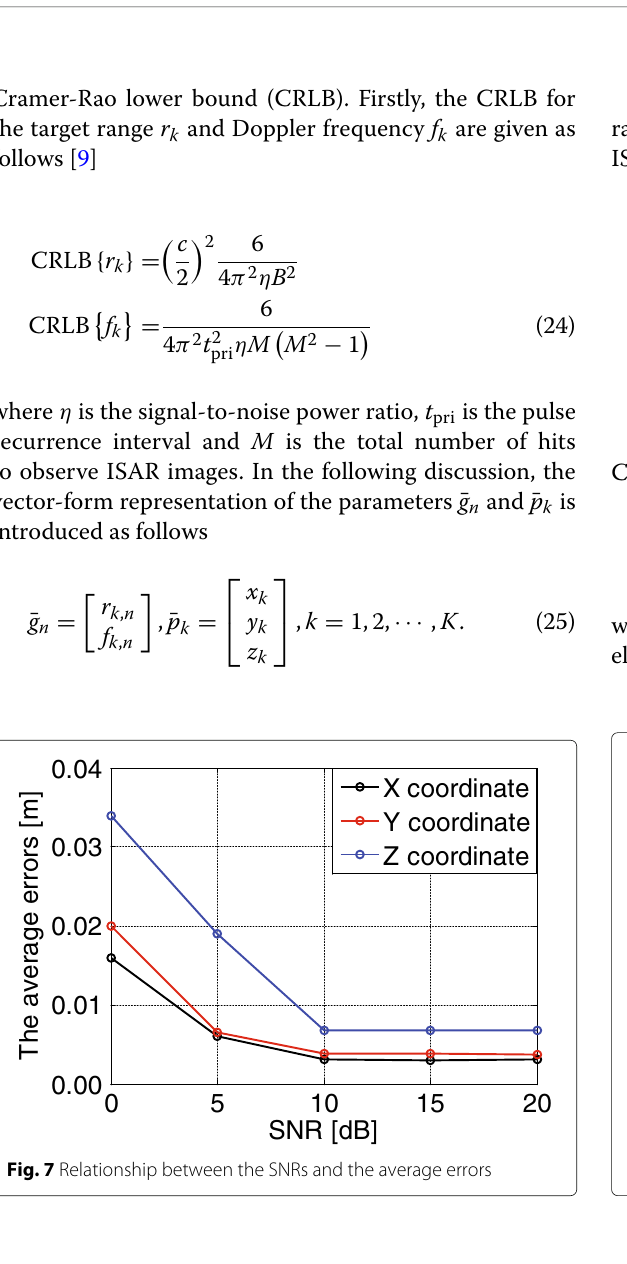
Fig. 6 The reconstruction accuracy for the algorithm. a The absolute errors in x coordinates. b The absolute errors in y coordinates. c The absolute errors in z coordinates